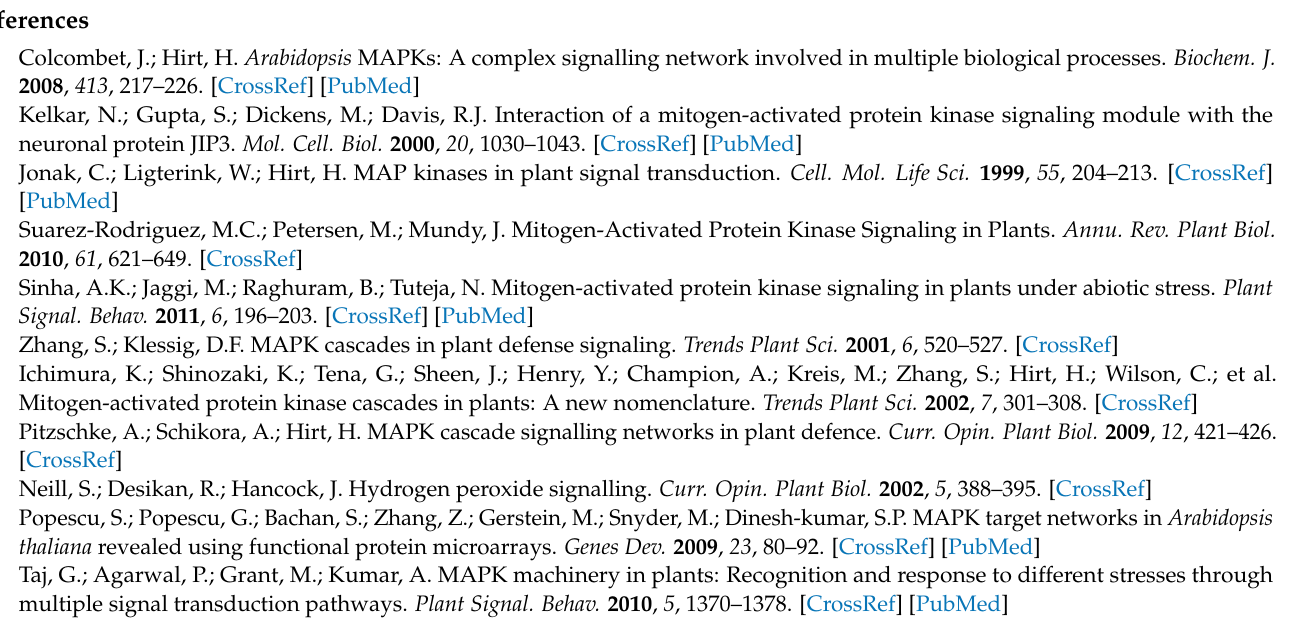
genomes; Table S2: Sequence length, molecular weight, and isoelectric point information for BnaMKK and BnaMAPK proteins predicted in B. napus ; Table S3: Sequence length, molecular weight, and isoelectric point information for BnaMKK and C group BnaMAPK proteins cloned in B. napus ; Table S4: Primers used to amplify and detect BnaMKK and C group BnaMAPK genes in this study. Figure S1, Yeast two-hybrid assays between BnaMKK and C group BnaMAPK proteins in the presence of 20 µ M ABA. (a) Protein interaction analysis between BnaMKK family members and BnaMAPK1 with ABA. (b) Protein interaction analysis between BnaMKK family members and BnaMAPK2 with ABA. (c) Protein interaction analysis between BnaMKK family members and BnaMAPK7 with